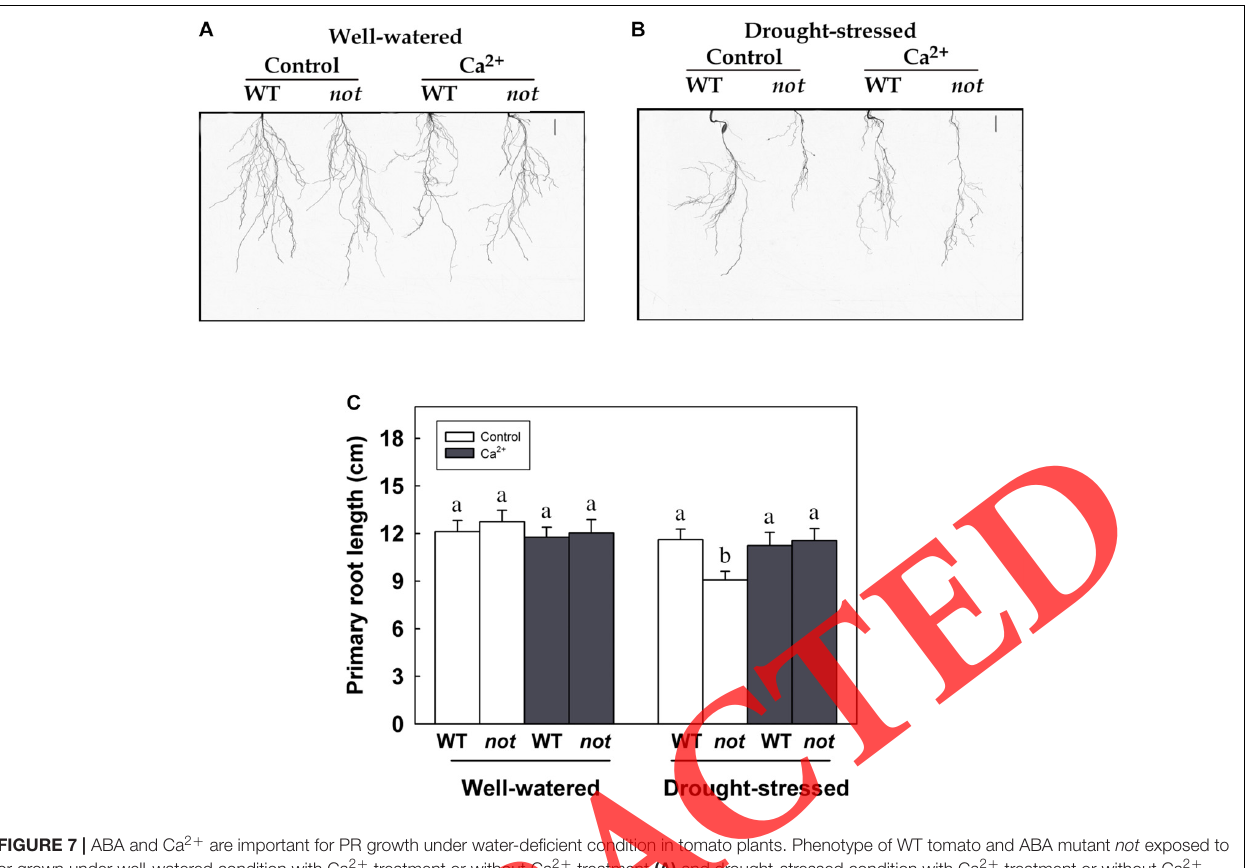
FIGURE 7 | ABA and Ca 2 + are important for PR growth under water-deficient condition in tomato plants. Phenotype of WT tomato and ABA mutant not exposed to or grown under well-watered condition with Ca 2 + treatment or without Ca 2 + treatment (A) and drought-stressed condition with Ca 2 + treatment or without Ca 2 + treatment (B) . After 4-day of germination, the homogeneous seedlings were transplanted to pots containing 14 and 5% water for well-watered and drought-stressed treatments, respectively. For the treatment of Ca 2 + , it was supplied daily in the form of 1 mM Ca 2 + to the bottom of the pot and thus the Ca 2 + could be absorbed by roots, while the control plants were supplied with equal volume of water. Eighteen-day old of plants were harvested and analyzed by WinRHIZO 2016a (Reagent Instruments Canada Inc.). (C) Measurement of PR length shown in panels (A,B) . The values are means, and error bars show ± SD of six biological replicates from three independent experiments ( n = 18). Bars with different lowercase letters represent significant difference at P < 0.05, as determined by a Tukey’s post hoc